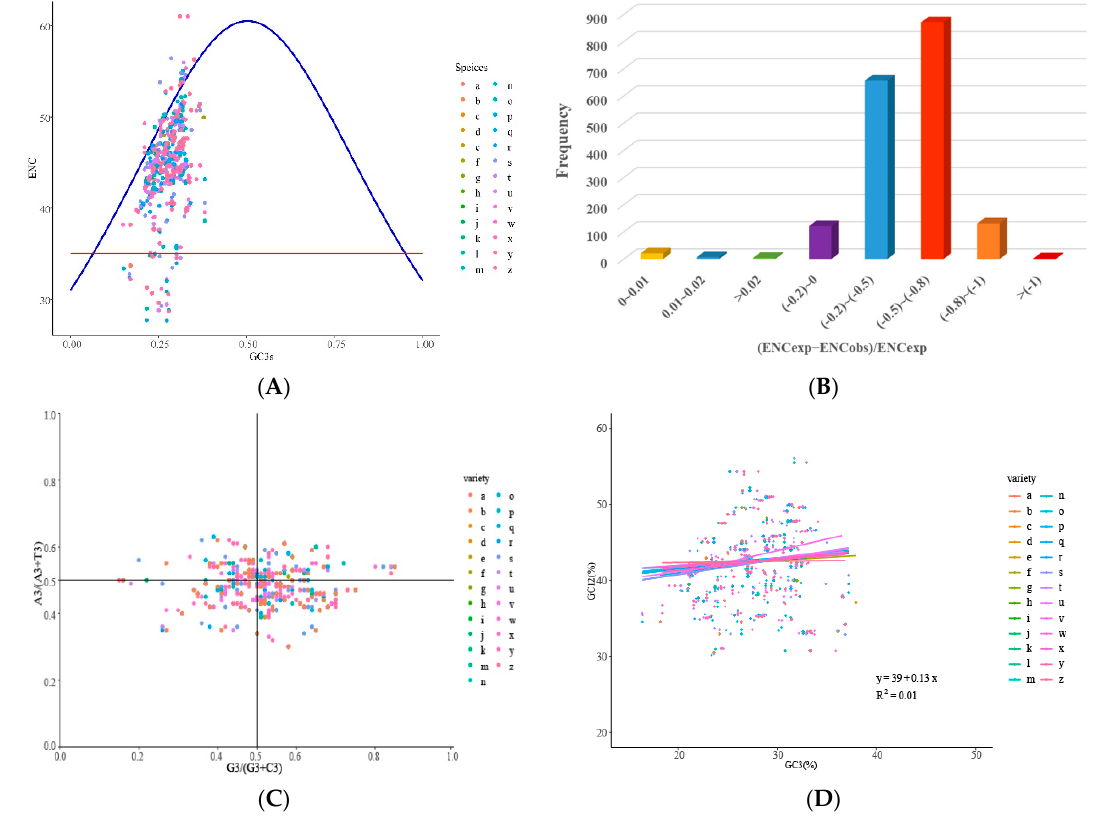
Figure 4. Analysis of codon preference influencing factors in Juglandaceae. ( A ) ENC-GC3 plot. The red line represents the expected curve when codon usage bias is only affected by mutation pressure, and the blue line represents the ENC value equal to 35, and the genes distributed below the red line represent strong codon preference, while those above the red line represent weak codon preference. ( B ) Frequency distributions of the ENC ratio. The dataset displayed a single peak, and the most of genes located into a narrow region of ENC ratios between − 0.5 and − 0.8. ( C ) PR2-bias plot using the values of A3/(A3 + T3) against G3/(G3C3). ( D ) Neutrality plot analysis of GC12 and